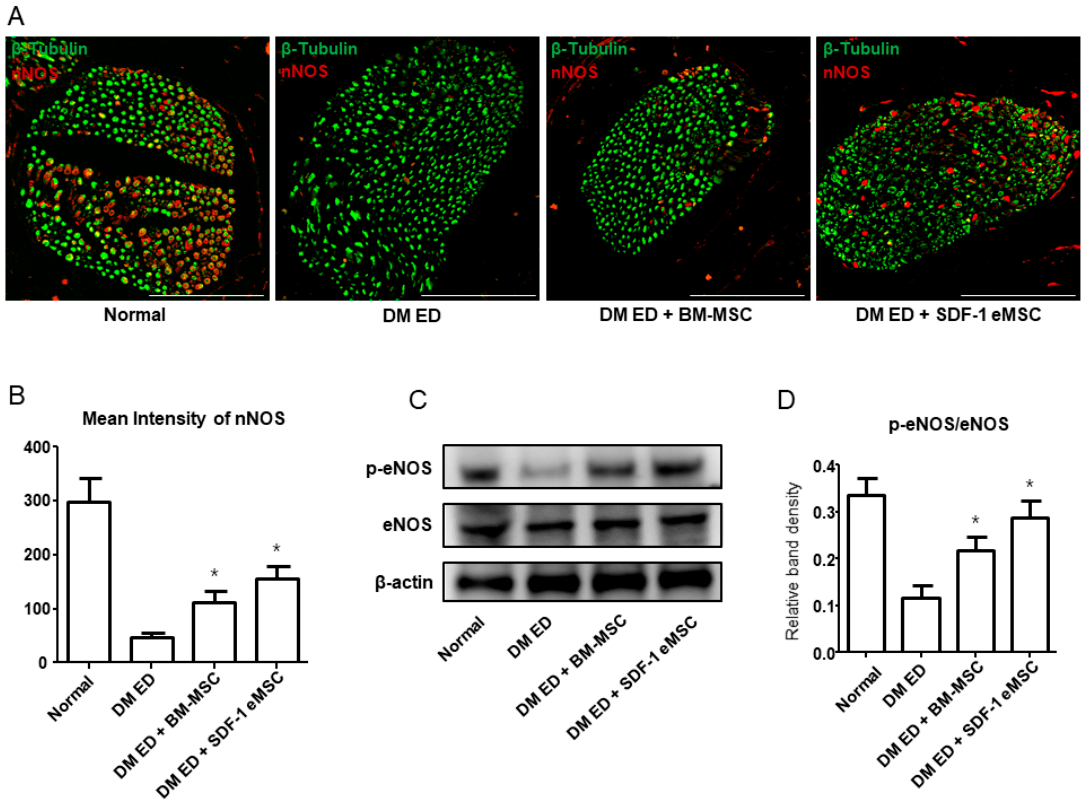
Figure 4. Representative images of neuronal nitric oxide synthase (nNOS) in the dorsal penile nerve. ( A ) Red indicates nNOS and green indicates the dorsal penile nerve. Scale bar: 100 µ m. Original magnification: × 400; ( B ) Mean intensity of nNOS for each group; ( C ) Western blot of phosphorylated endothelial nitric oxide synthase (p-eNOS) and eNOS expression in the corpus cavernosum; ( D ) Quantitative results of p-eNOS/eNOS in each group. Each bar shows the mean value (standard deviation). * p < 0.05 compared with the diabetes mellitus erectile dysfunction (DM ED) group.